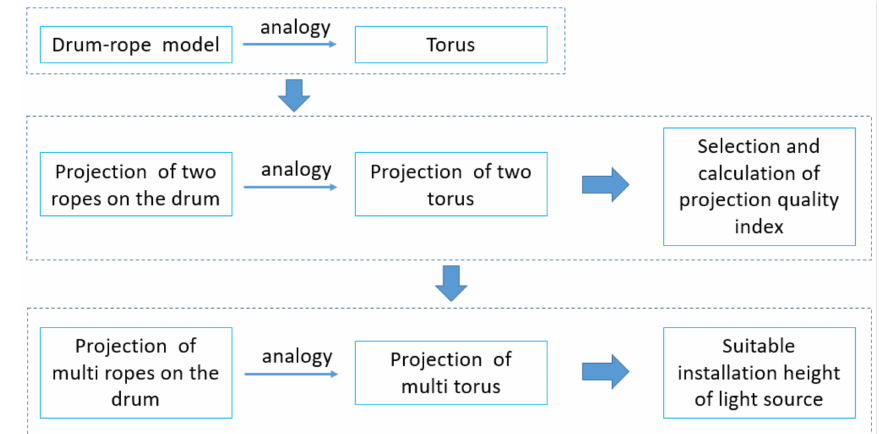
Figure 2. The flowchart of how to get the required